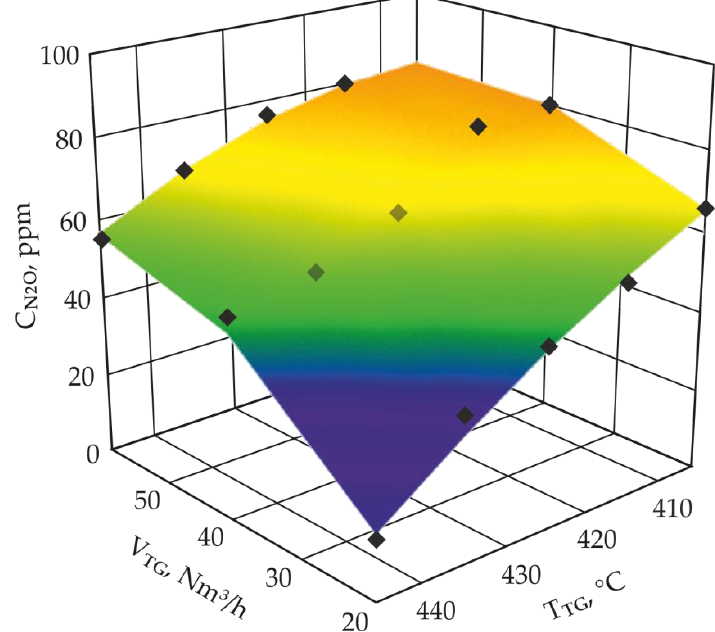
Figure 4. The dependence of N 2 O concentration in the tail gas stream downstream of the LT-deN 2 O catalyst layer on the tail gas temperature and tail gas flow rate. N 2 O concentration in tail gas at the inlet equals 80 ppm.